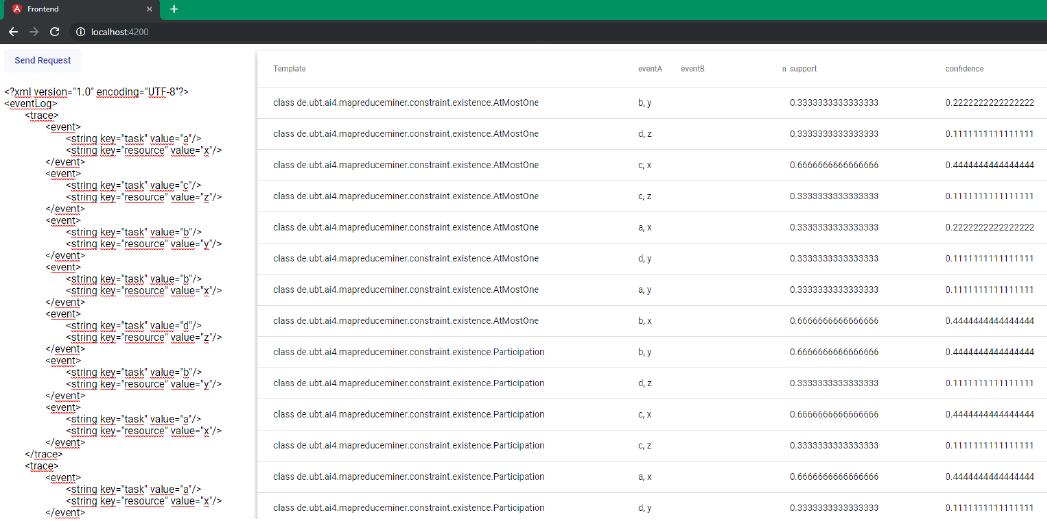
Figure 5. User interface to start a new mining